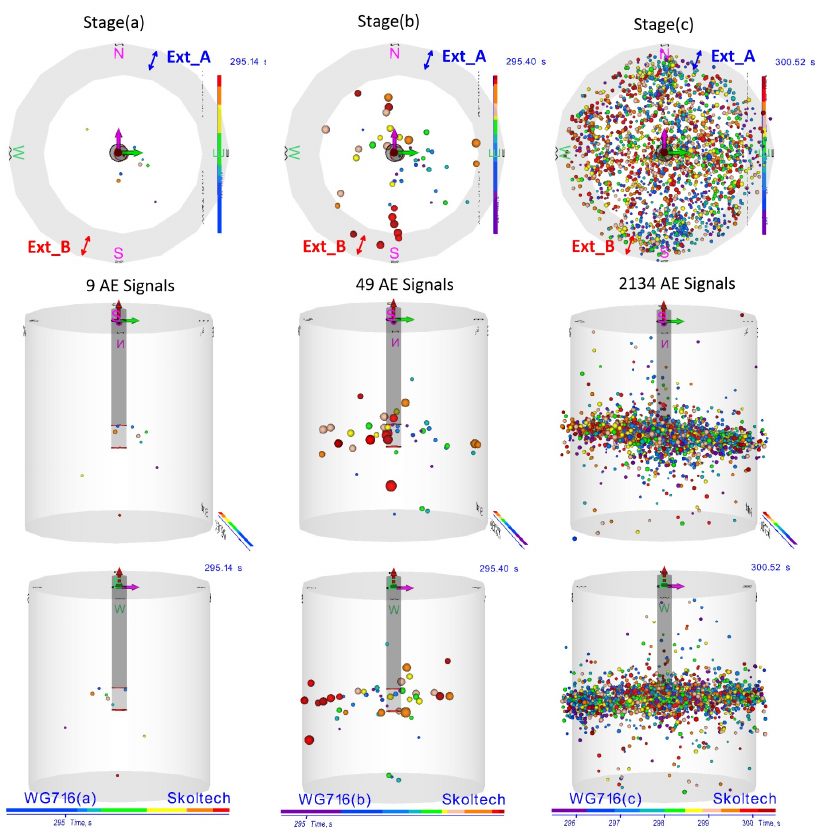
Figure 10. Three orthogonal projections of positions of AE signals in the space of the WG-716 sam- ple.